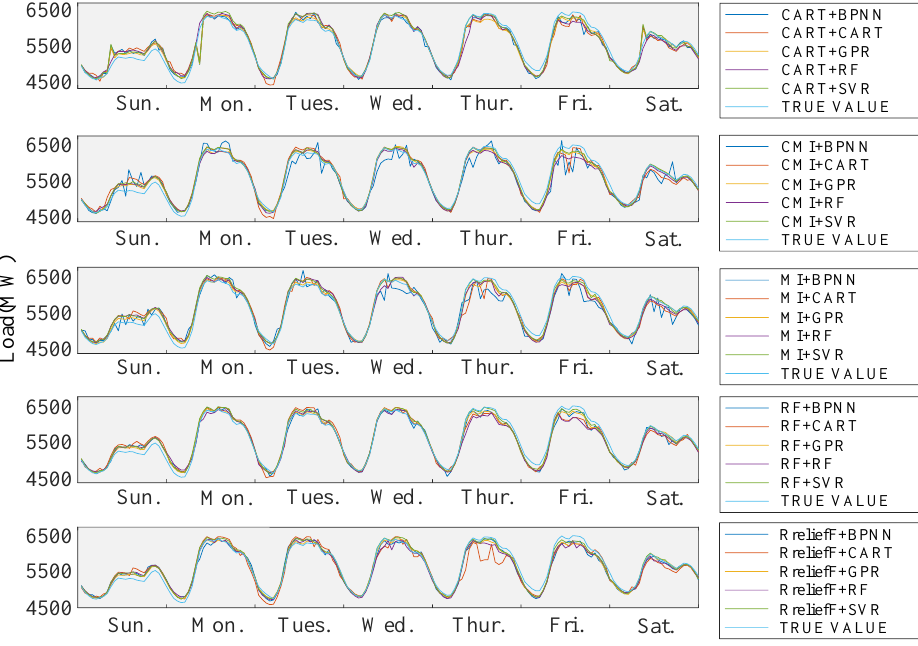
Figure 7. Prediction from 21 to 27 June 2015. Energies 2018 , 11 , x FOR PEER REVIEW Table 11. Comparison of different combined methods.